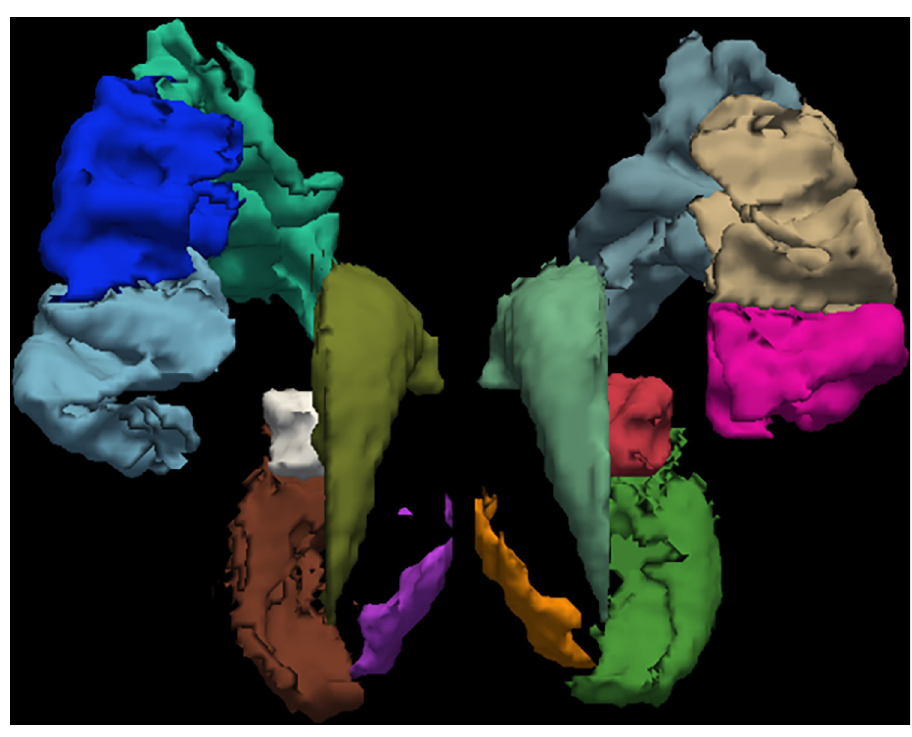
Fig 1. Example segmentation of the